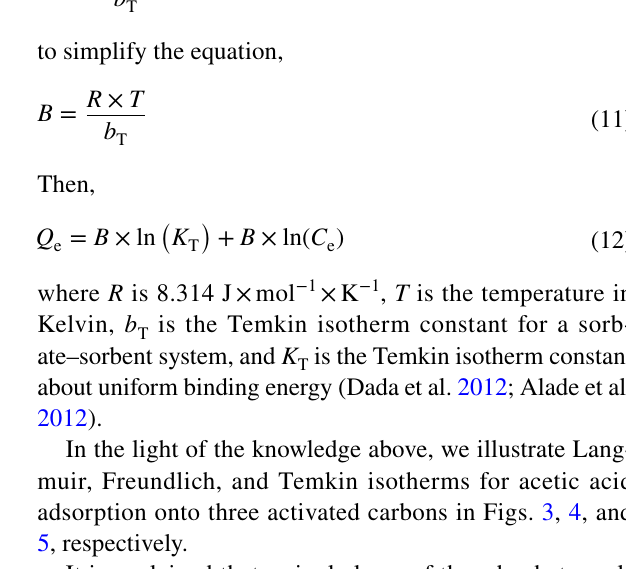
e ) and adsorption capacities (